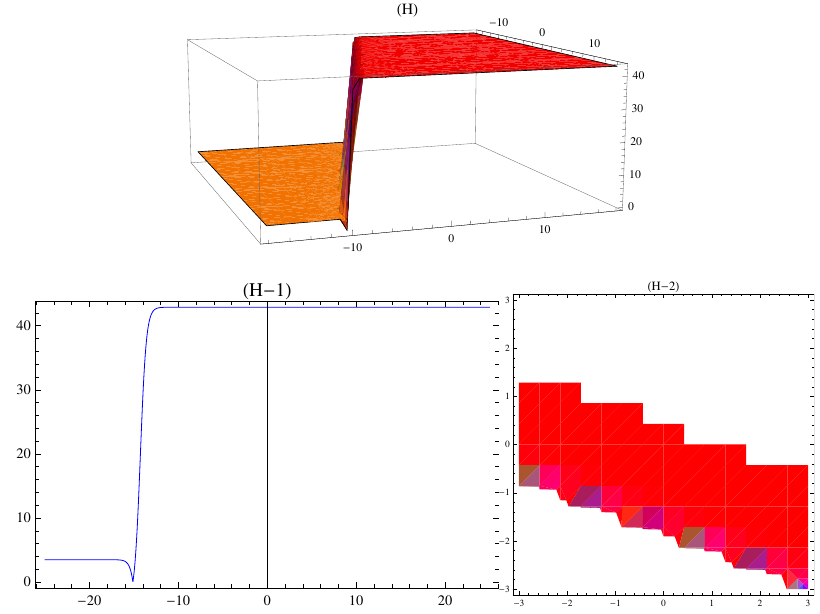
Figure 8: (H) 3D graph of (82) with θ = 2.4 , λ = 2.2 , µ = 1.2 , Θ = 1.7 , p = 0.98 , q = 0.95 , k = 2.4 , A = 2.1 , δ = 2 , ς = 2 , c = 3.3 , y = 2.8 , l = 1.1 . (H-1) 2D plot of (82) with t = 1 . (H-2) Contour graph of (82).